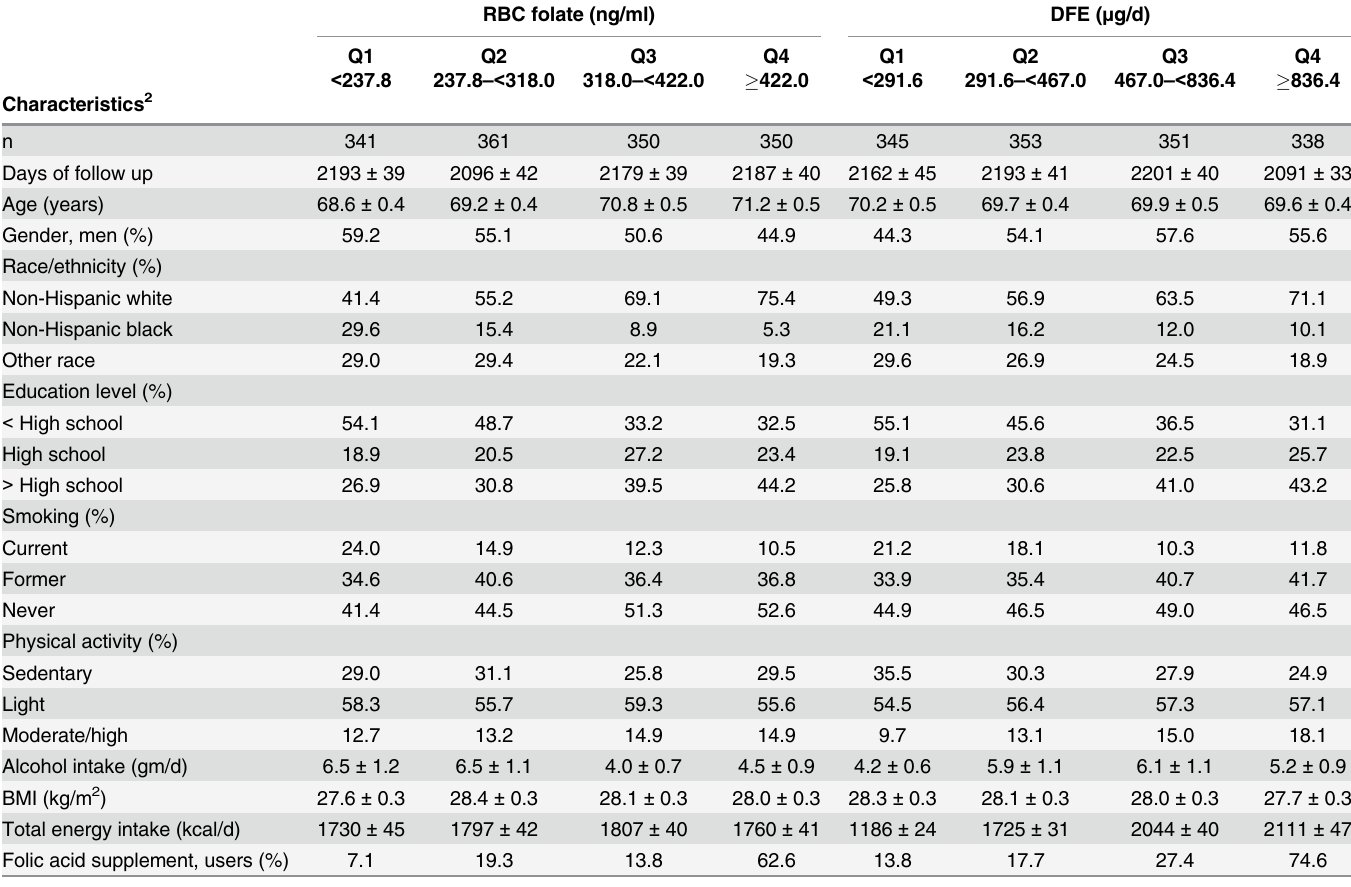
Table 1. Characteristics of NHANES 1999 – 2002 participants by quartiles (Q) of red blood cell (RBC) folate and dietary folate equivalents (DFE) 1